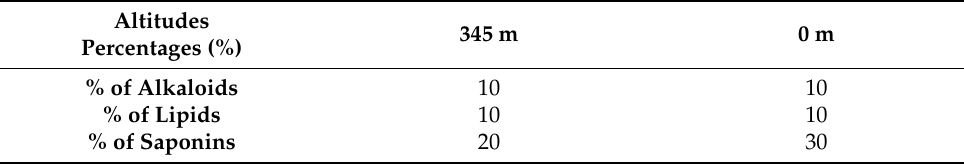
Table 4. Percentages of alkaloids, lipids, and saponins in E. camaldulensis .